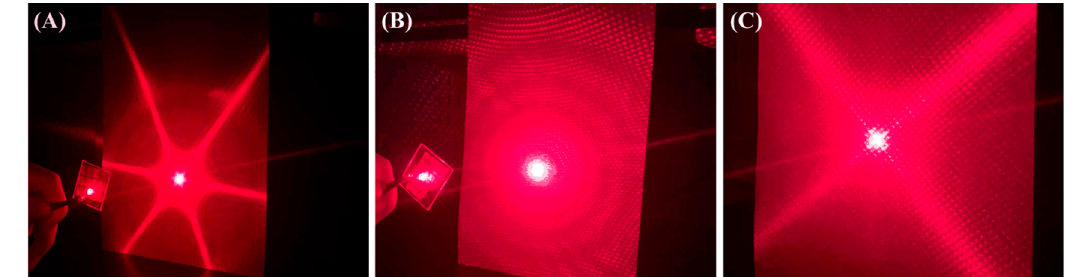
Figure 7. Diffraction patterns of a laser beam passing through the hybrid film MLAs, ( A ) hexagonal MLAs, ( B ) circular MLAs, and ( C ) square MLAs.